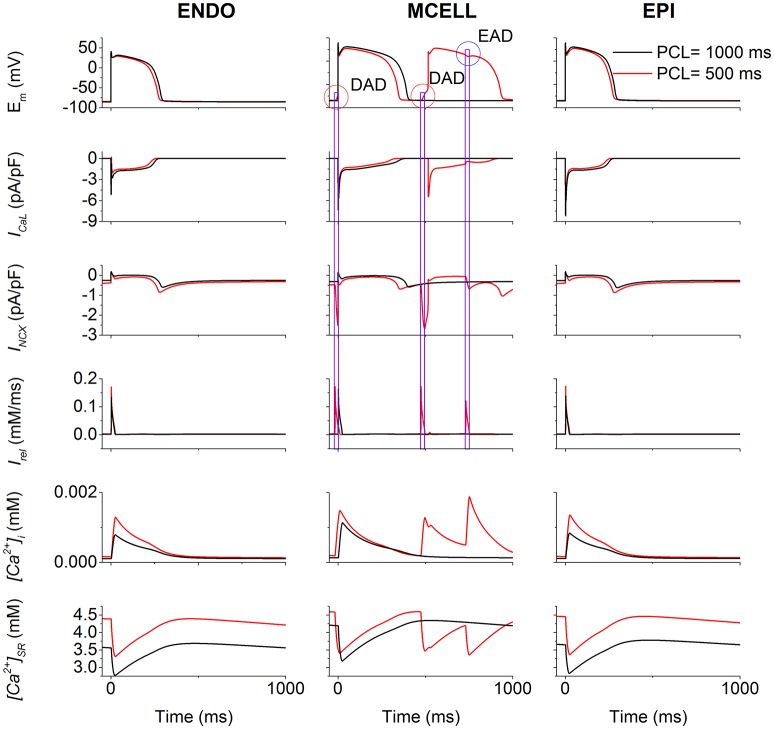
Effects of the R858H L-type calcium current (ICaL) on the induction of afterdepolarizations. For endocardial (ENDO, left column), midmyocardial (MCELL, middle column) and epicardial (EPI, right column) cells, time courses of membrane potential (Em), underlying L-type calcium current (ICaL), the sodium-calcium exchanger current (INCX), calcium induced calcium release flux (Irel), cytoplasmic calcium concentration ([Ca2+]i) as well as sarcoplasmic reticulum (SR) calcium concentration ([Ca2+]SR) at the pacing cycle length (PCL) of 500 (Red) and 1,000 ms (Black), respectively. Among different cell types, in MCELL cells early afterdepolarizations (EAD, marked with a blue circle) and delayed afterdepolarizations (DAD, marked with a red circle) occurred at the PCL of 500 ms. These afterdepolarizations were triggered by Irel via INCX.